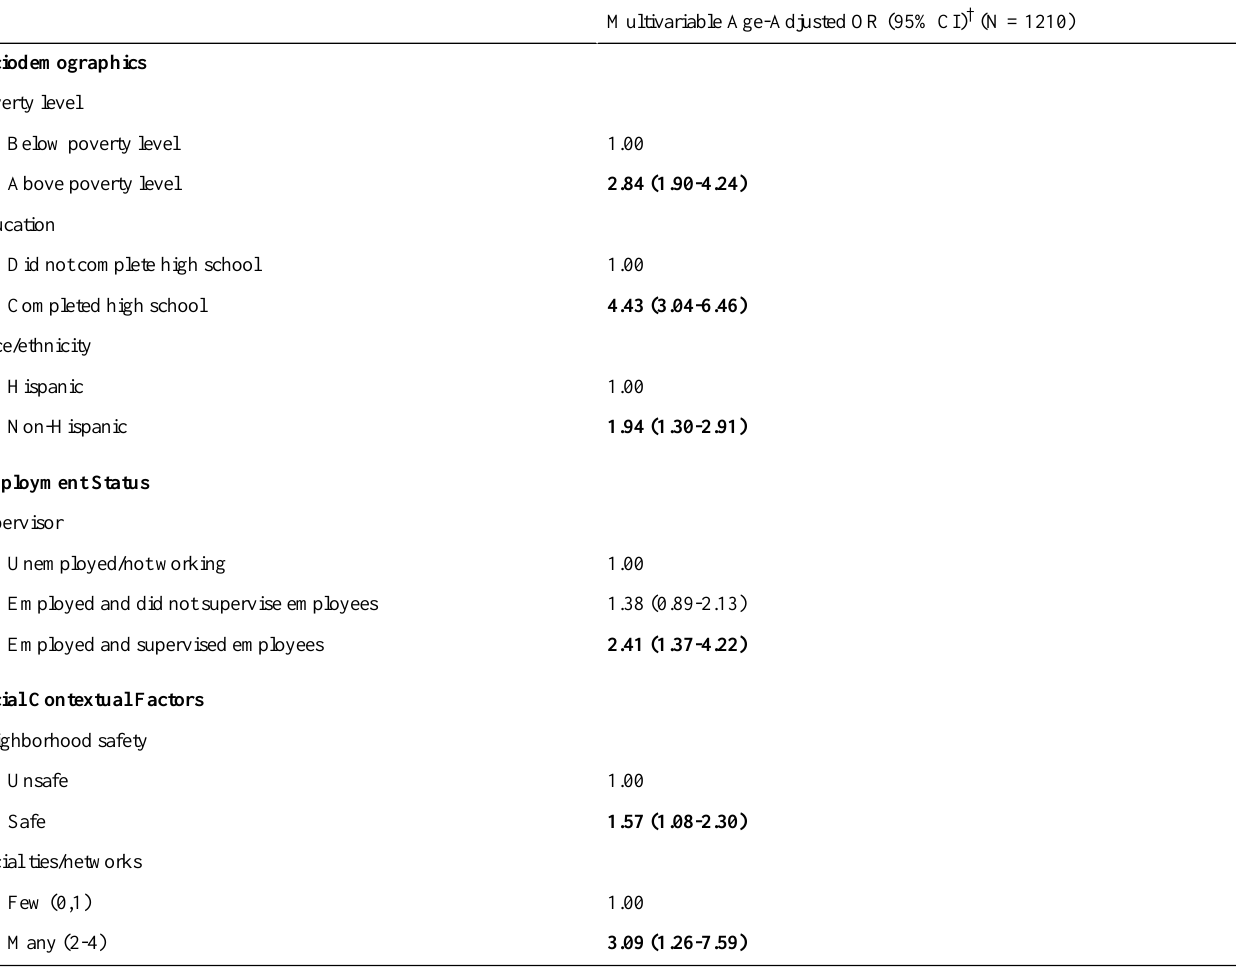
Table 4. Predicting computer use (regular versus intermittent/never